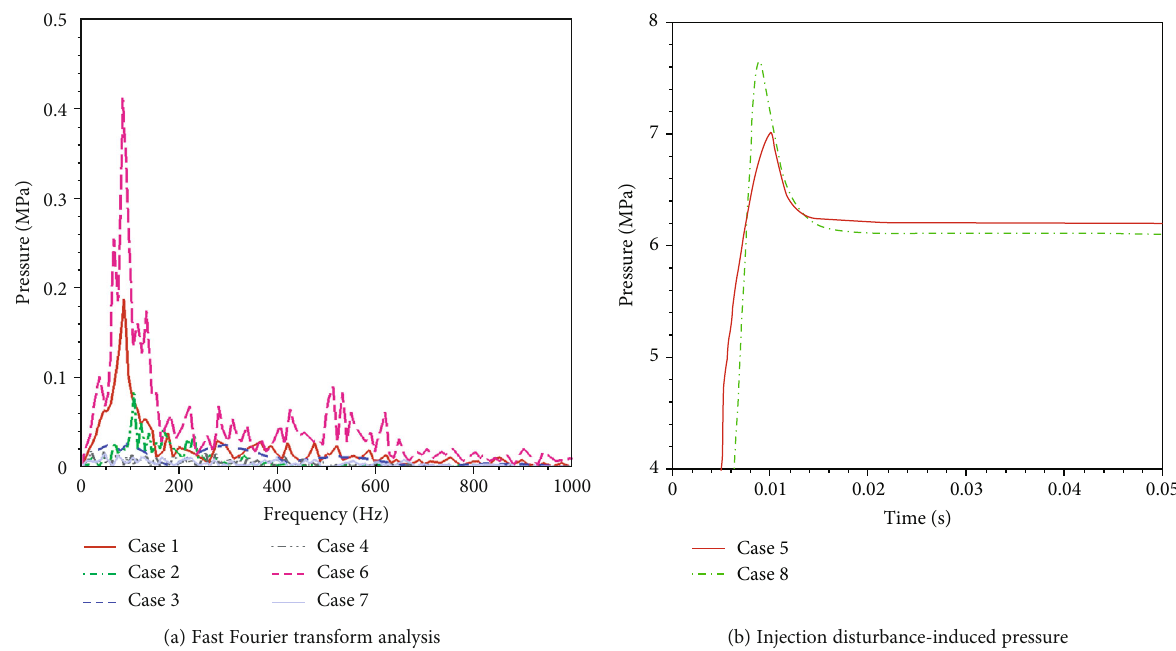
Figure 7: The numerical results of combustion stability